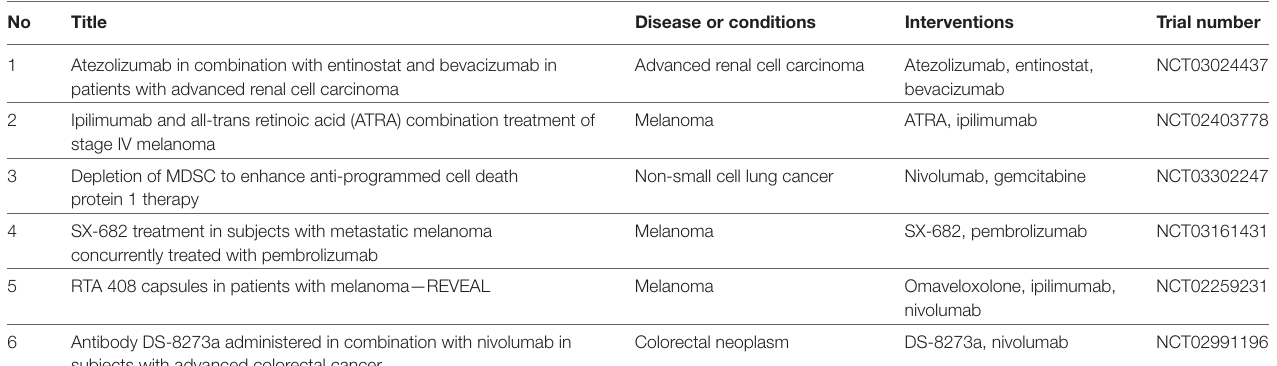
TABLe 1 | Clinical trials combining myeloid-derived suppressor cell (MDSC) targeting with immune checkpoint inhibitors (ICI) in cancer patients. Disease or conditions interventions Trial number Atezolizumab in combination with entinostat and bevacizumab in patients with advanced renal cell carcinoma